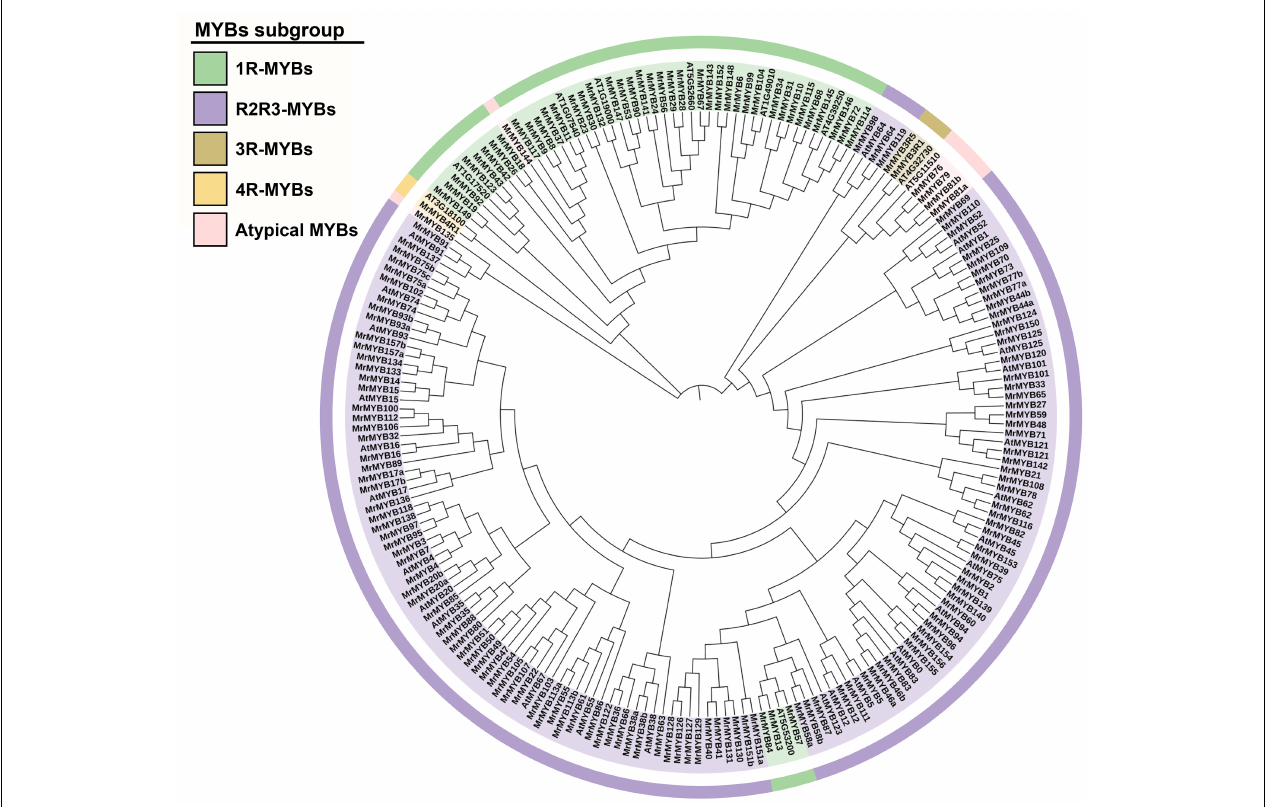
FIGURE 1 | Phylogenetic analysis of MYB proteins from Chinese bayberry and Arabidopsis. A Neighbor-joining phylogenetic tree was constructed by aligning the full-length predicted amino acid sequences of 174 MrMYBs with 37 Arabidopsis MYBs. The classes are shown in different